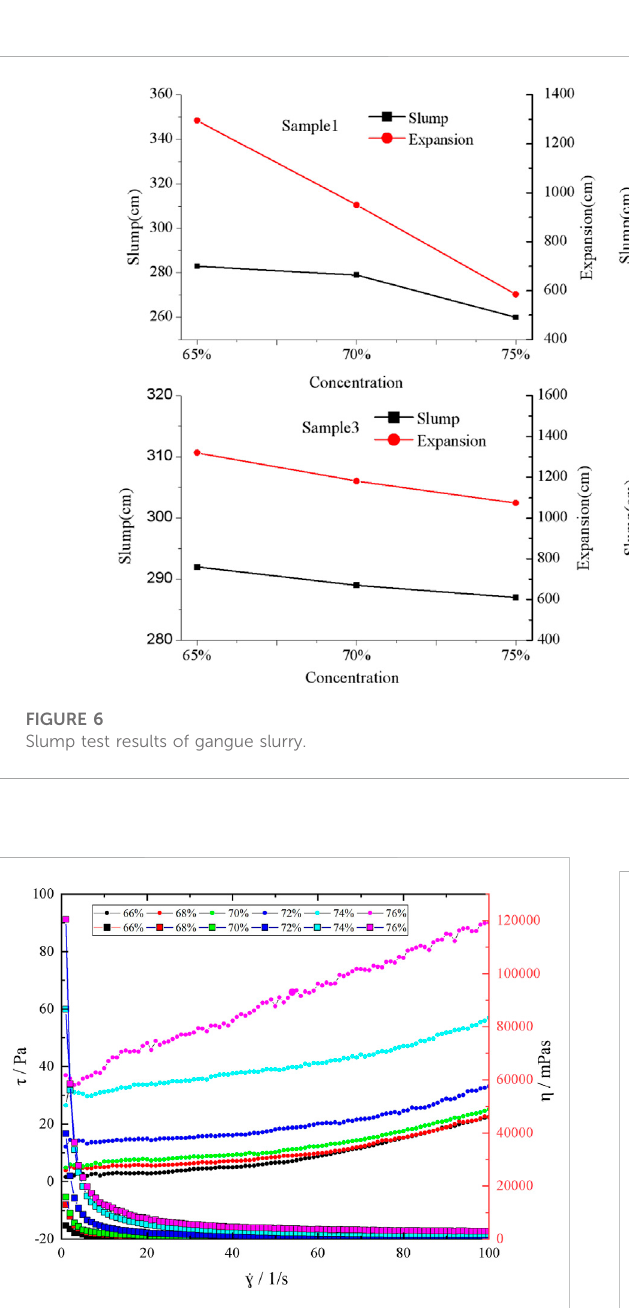
FIGURE 7 Rheological characteristic curve of gangue slurry with different concentrations.